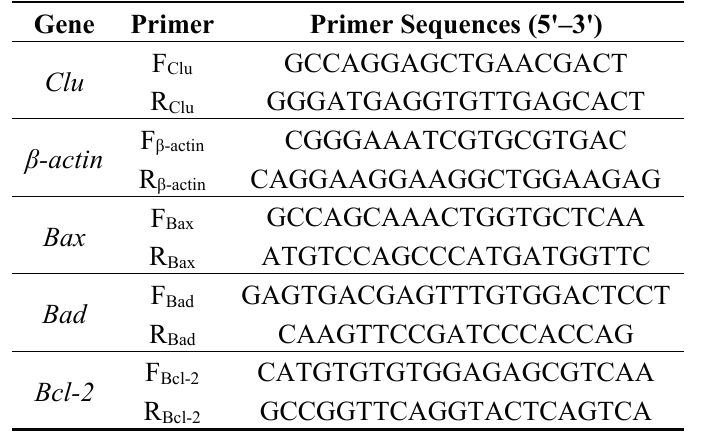
Table 3. Primer sequences used for real-time RT-PCR